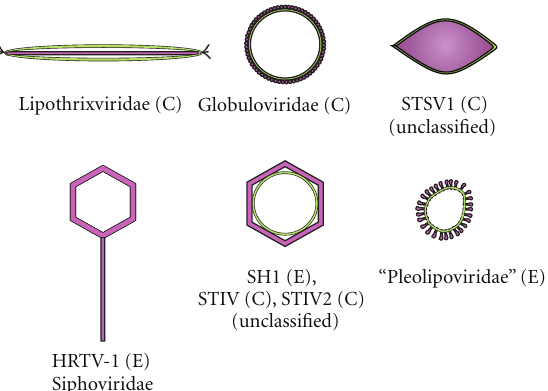
Figure 1: Schematic representation of the currently known lipid containing archaeal viruses (C = viruses infecting crenarchaeal hosts, E = viruses infecting euryarchaeal hosts). As a comparison, an archaeal virus devoid of a membrane [32] is also shown. Membrane is illustrated as a yellow layer either inside or outside of the protein capsid depicted in purple. The viral particles are not drawn in